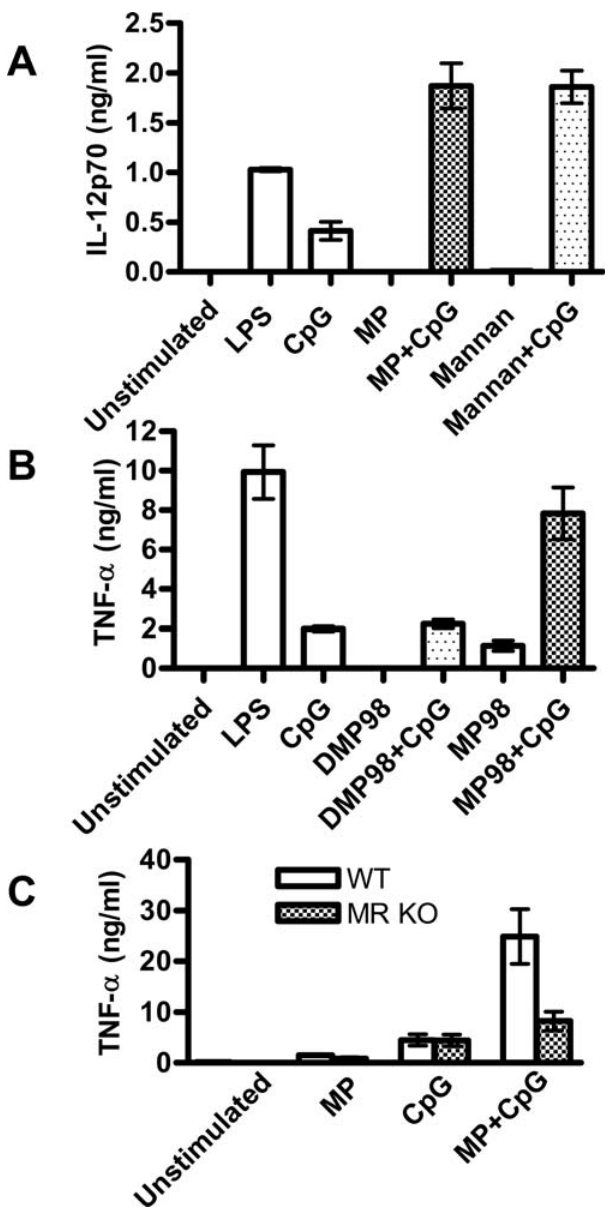
Figure 3. Mannose residues and the MR are critical for synergistic stimulation of cDCs with MP and CpG. (A) cDCs were incubated for 24 hours with 1 m g/ml LPS, Control ODN 2138 (10 m g/ml), CpG ODN 1826 (10 m g/ml), mannan (1 mg/ml), mannan (1 mg/ml) + CpG (10 m g/ml), MP (10 m g/ml), or MP (10 m g/ml) + CpG (10 m g/ml). Super- natants were analyzed by ELISA for IL-12p70. p , 0.001 comparing